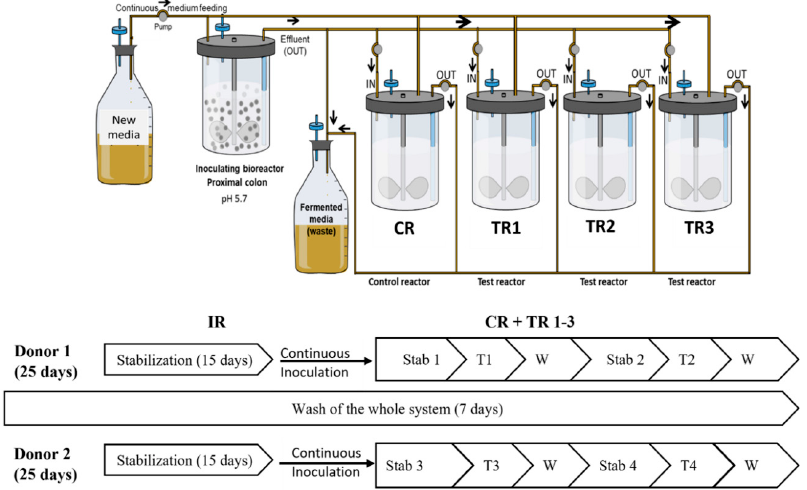
Figure 7. Experimental reactor set-up of the ex vivo fermentation model. IR: inoculum reactor, con- taining immobilized donor feces (30% v / v ); CR: control reactor; TR1-TR3: test reactors 1–3; Stab: stabilization period (2 days); T: treatment period (2 days); W: wash period (1